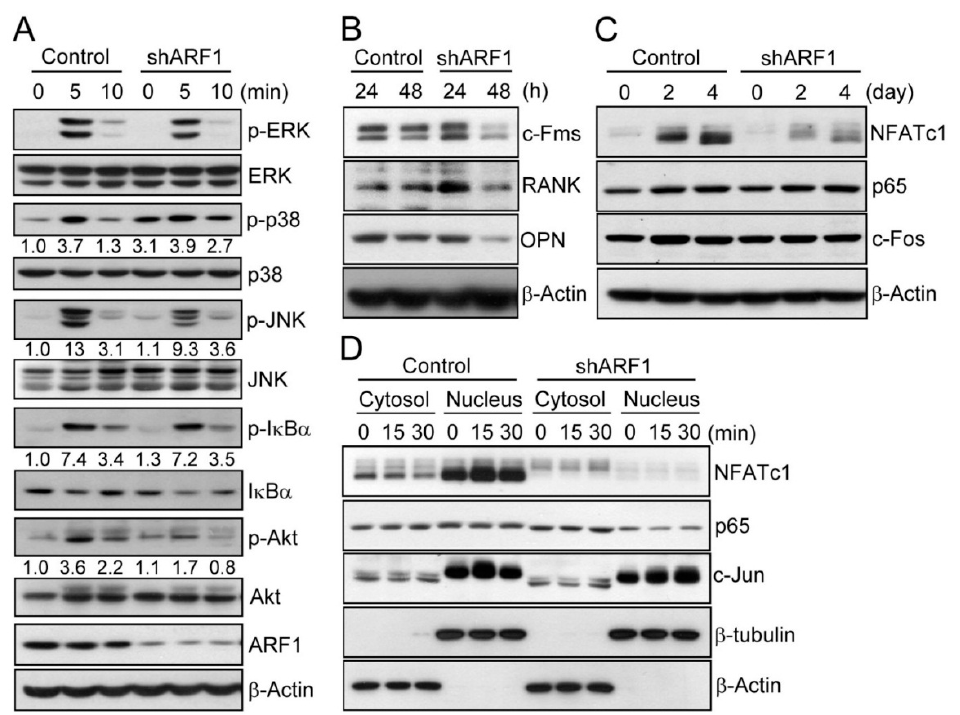
Figure 4. Analysis of osteoclastogenic signals in ARF1-deficient cells. Osteoclast precursors were infected with ARF1 shRNA lentiviral particles or pLKO.1-puro empty control virus particles. ( A ) After cells were treated with RANKL (100 ng/mL) for 0, 5, and 10 min, total or active phosphorylated forms of ERK, p38, JNK, I κ B α , and Akt were determined using immunoblot analysis. Fold differences of expression levels were presented; ( B , C ) Osteoclast precursors were treated with M-CSF (30 ng/mL) and RANKL (100 ng/mL) for the indicated times and subjected to immunoblot analysis with specific antibodies to c-Fms, RANK, and osteopontin (OPN), NFATc1, p65, and c-Fos; ( D ) Nuclear translocation of NFATc1, p65, and c-Jun was analyzed in the pre-osteoclast stage. After osteoclast precursors were cultured in medium containing M-CSF (30 ng/mL) and RANKL (100 ng/mL) for 2 days, TRAP-positive mononuclear pre-osteoclasts were incubated in the absence of M-CSF and RANKL for 5 h and then treated with RANKL (100 ng/mL) for 0, 15, and 30 min. Cytosolic and nuclear fractions were prepared and subjected to immunoblot analysis. β -Actin and β -tubulin were examined as loading controls. All data are representative of three independent experiments.